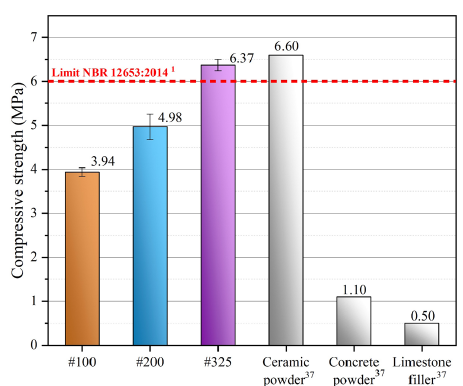
Figure 7. Compressive strength results of PAI tests with lime for the studied grain sizes of glass powder and comparison with ceramic and concrete waste powders, as well as limestone filler 37